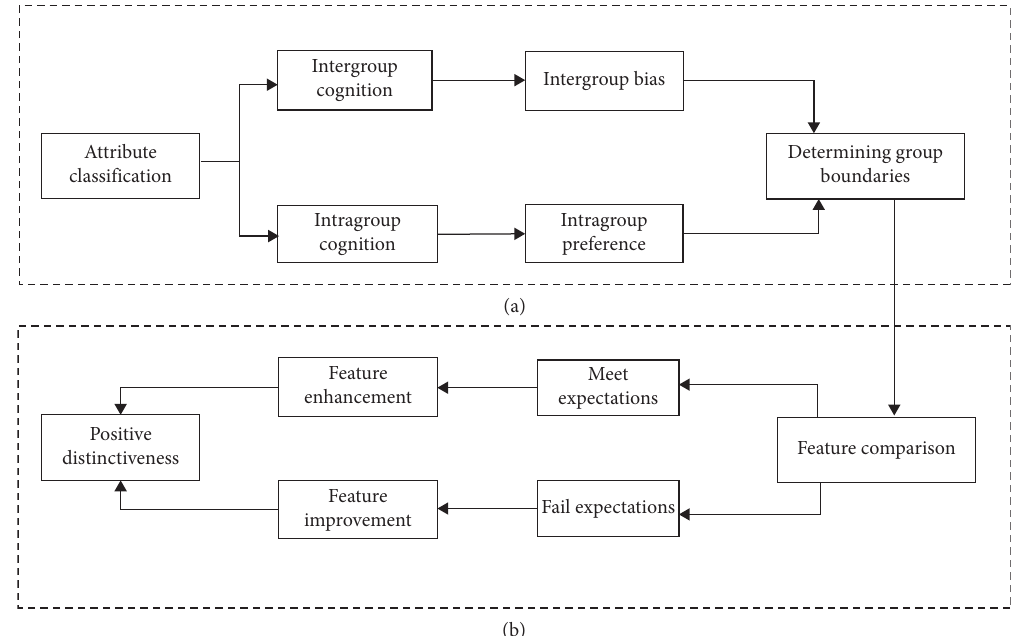
Figure 2: Formation of social identity. (a) The self-categorization process. Everyone can be subordinated to one or more social groups according to different attributes. Also, each group has the same attribute. At the same time, to distinguish the subordinate groups from other groups, an individual’s cognition of the in-group similarity will continue to increase, and the out-group differences will continue to expand, thus forming obvious attributes and behavioral characteristics belonging to a certain group. (b) The social comparison process. It focuses on establishing positive heterogeneity for one’s group. Positive heterogeneity is a precondition for the formation of social